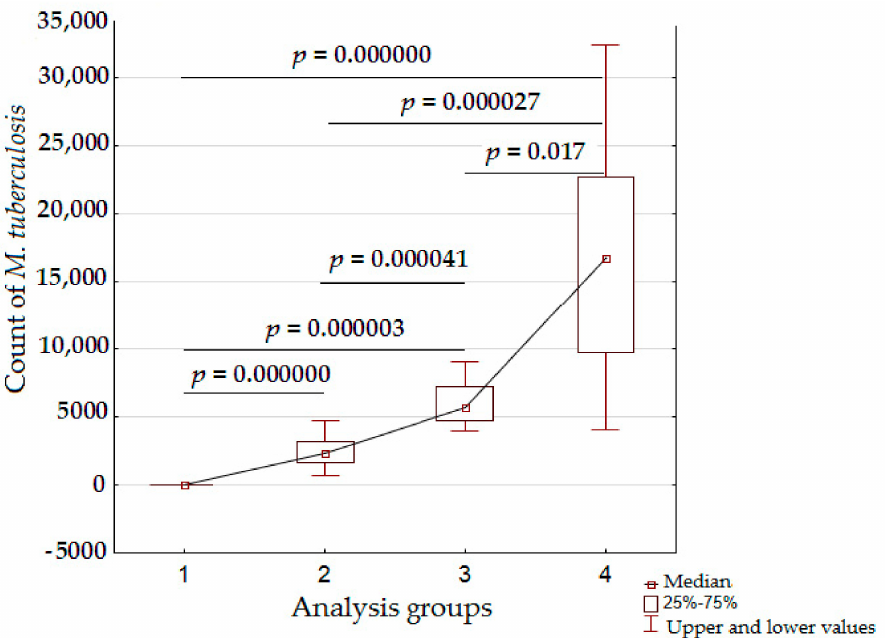
Figure 6. Comparison of the detected density of M. tuberculosis in staining according to Ziehl–Neelsen and immunohistochemical staining of samples of 5, 20, and 40 µ m-thick lung tissue optical slices. Analysis groups: ( 1 )Ziehl–Neelsen staining, 5 µ m-thick slices; 2–4, ICC-staining; ( 2 ) 5 µ m-thick slices; ( 3 ) 20 µ m-thick slices; ( 4 ) 40 µ m-thick slices. The abscissa shows number of observations per slices 500 µ m 2 ; the ordinate shows the group of